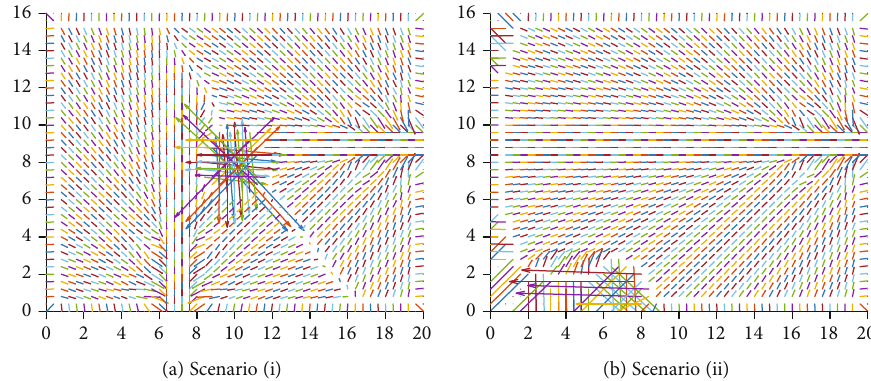
Figure 8: Negative gradient of the arrival times of 300 pedestrians in scenario (i) and scenario (ii) at t = 5s